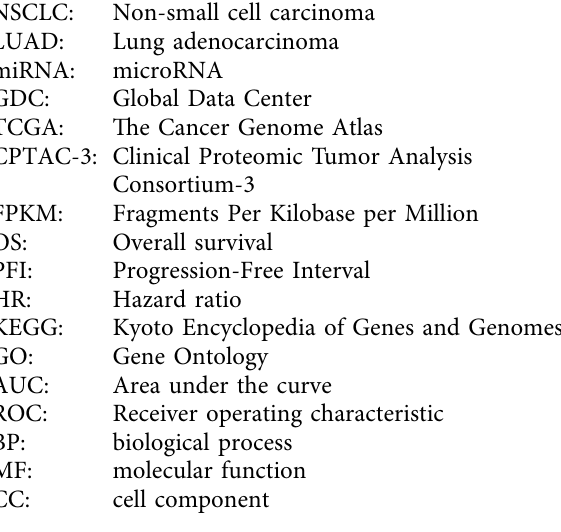
Figure S1: Support vector machine model prediction of six miRNAs in GSE175462 dataset and EGFR survival analysis. A: SVM model ROC curve; B: Confusion matrix visuali- zation; C: EGFR log-rank analysis results. ( Supplementary Materials